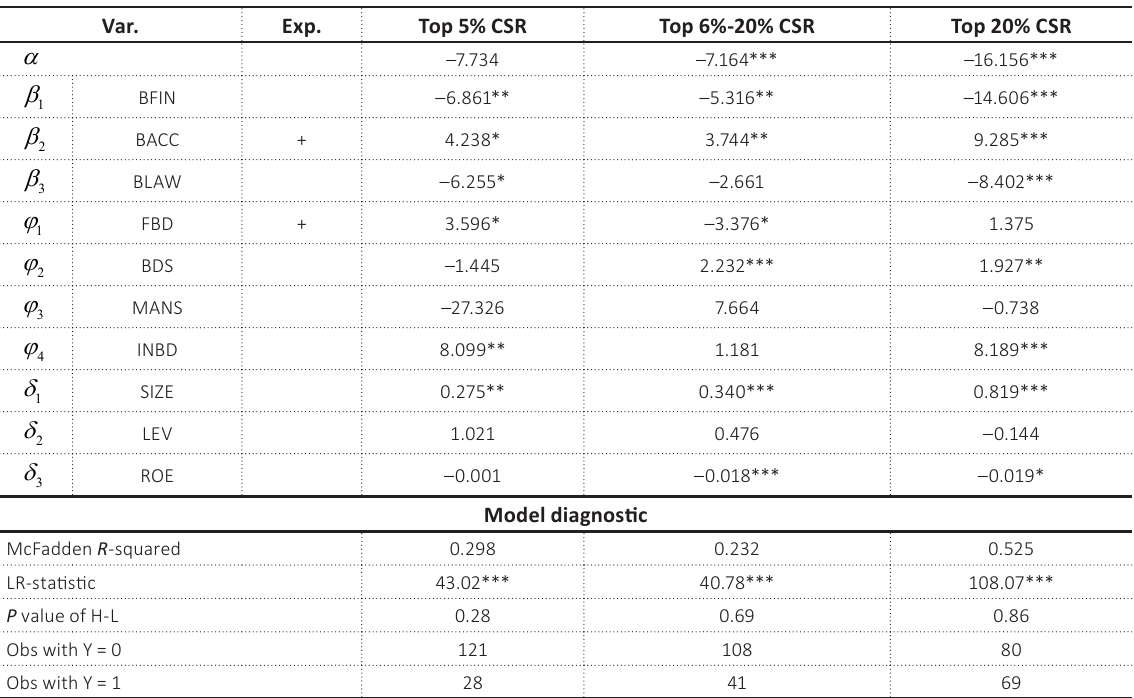
Table 4. The impact of board gender and accounting background on CSR (probit regression analysis for the case of more than 11 board members)